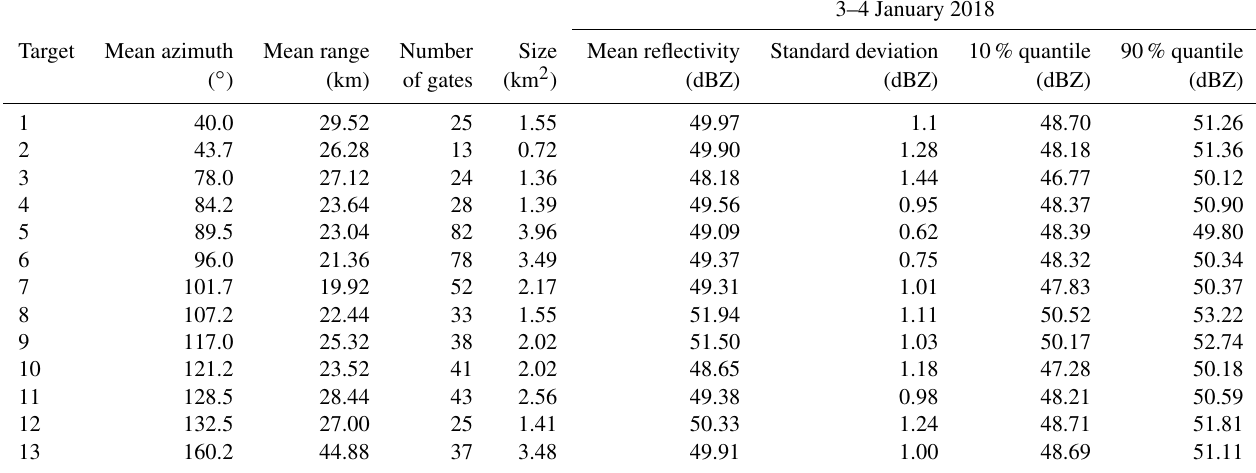
Table 4. Geometrical characteristics and apparent reflectivity statistics for the 13 mountain targets selected for the MOUC radar at an elevation angle of 0 ◦ . The mean, standard deviation, and 10% and 90% quantiles of the apparent reflectivity time series are computed over the period of 3 January 2018 from 19:00 to 23:55UTC, preceding the rising of the ML at the level of the MOUC